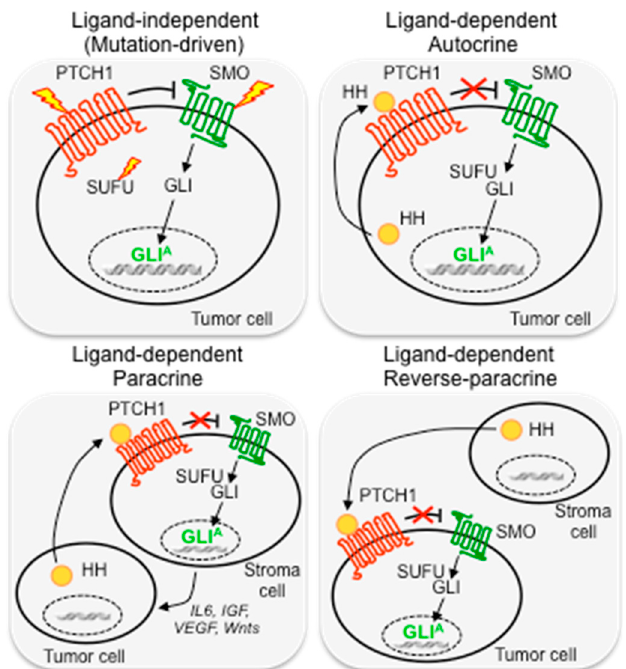
Figure 2. Mechanisms of Hedgehog pathway activation in cancer. Ligand-independent activation is due to inactivating mutations in the negative regulators PTCH1 or SUFU, activating mutations in SMO, or amplification of GLI activators. Ligand-dependent activation occurs through autocrine, paracrine, or inverse paracrine mechanisms (see text for details). In the autocrine mechanism, tumor cells secrete and respond to HH ligands; in the paracrine pattern tumor cells produce HH ligands, which activate HH pathway in stroma cells; in the reverse-paracrine mechanism stroma cells produce HH ligands, which activate HH pathway in tumor cells. PTCH1, Patched 1; SMO, Smoothened; SUFU, Suppressor of Fused; HH, hedgehog ligand; GLI A , GLI activators; IL6, Interleukin-6; IGF, Insulin Growth Factor; VEGF, Vascular Endothelial Growth Factor; Wnt, Wingless/Integrated.